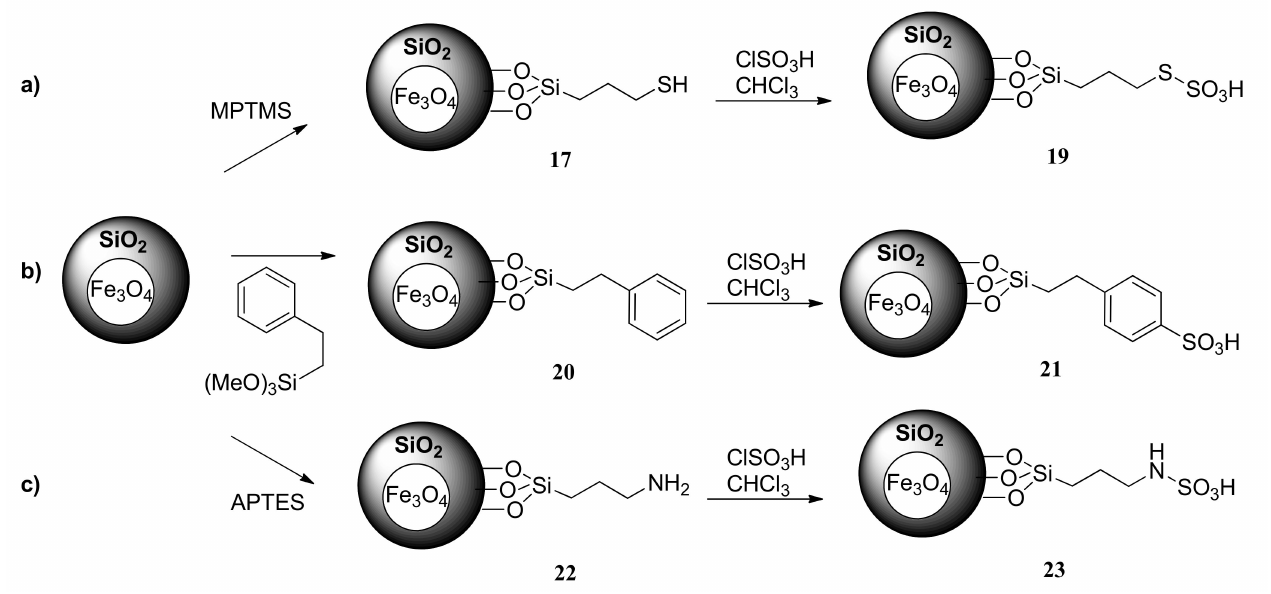
Figure 8. Sulfonic magnetic silica materials synthesized by ( a ) Moradi et al. [38], ( b ) Mobaraki et al. [39] and ( c ) Kas- saee et al. [40],